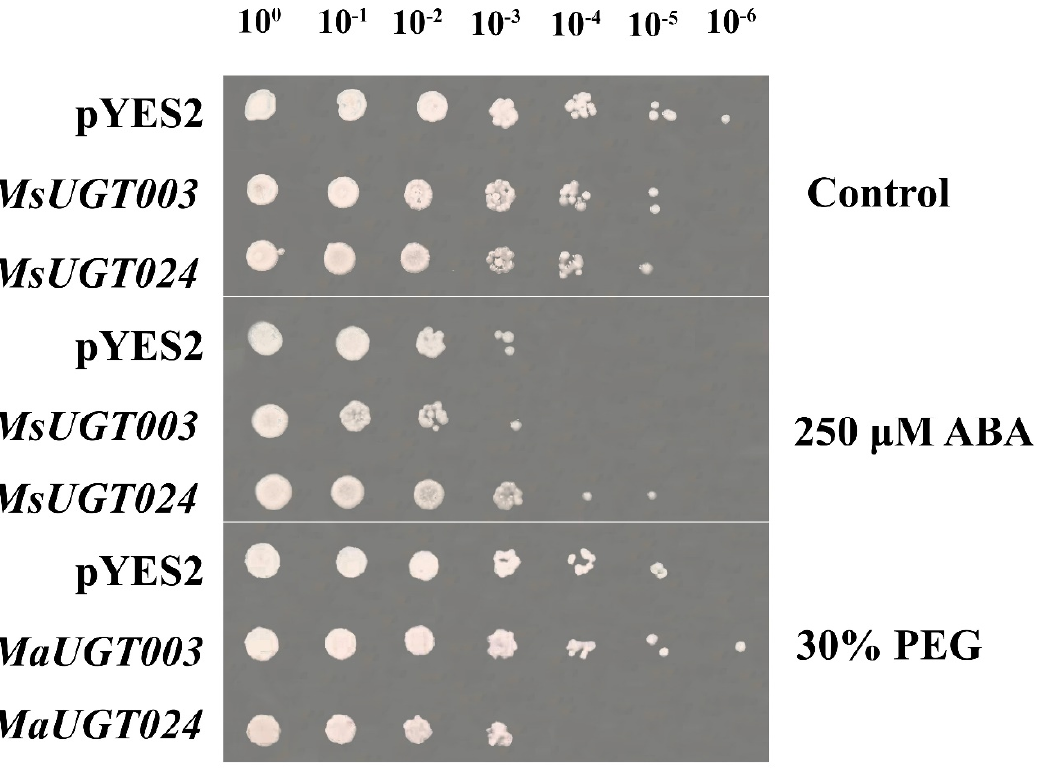
Figure 6. qRT-PCR results of the relative expression of twelve selected MsUGT genes in response to drought stress and ABA treatment in shoot and root. CK, MD, SD and ABA represent the control condition, mild and severe drought and ABA treatments, respectively. Asterisks indicate the signif- icance compared with CK; * represents significant ( p < 0.05) and ** represent highly significant ( p < 0.01). The error bars indicate the standard errors of three biological replicates.